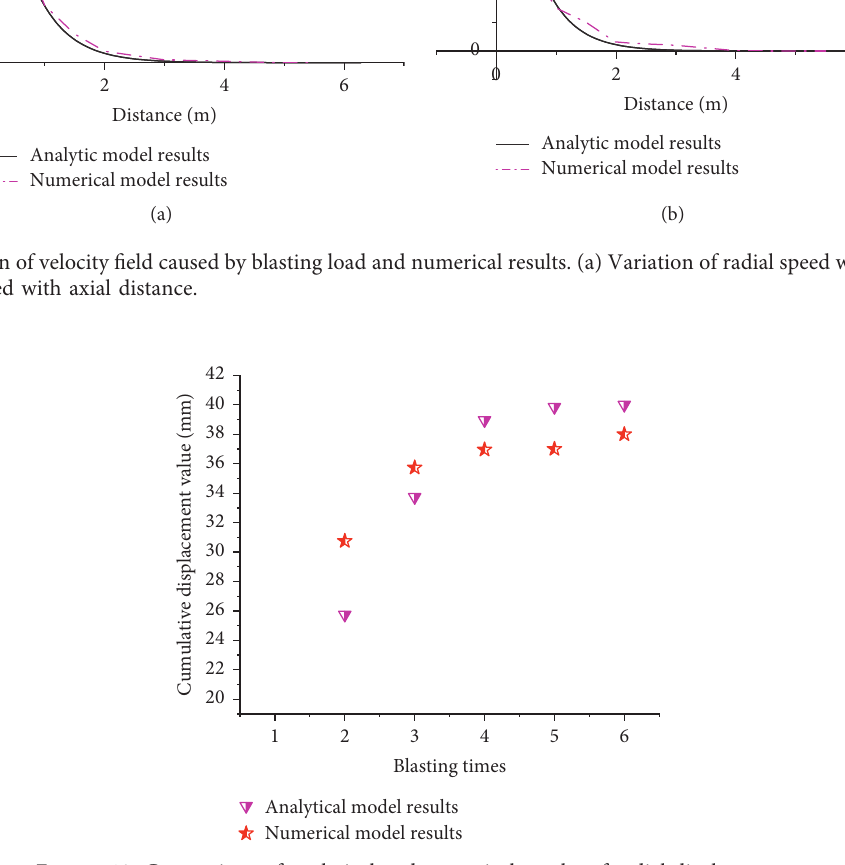
Figure 13: Comparison of analytical and numerical results of radial